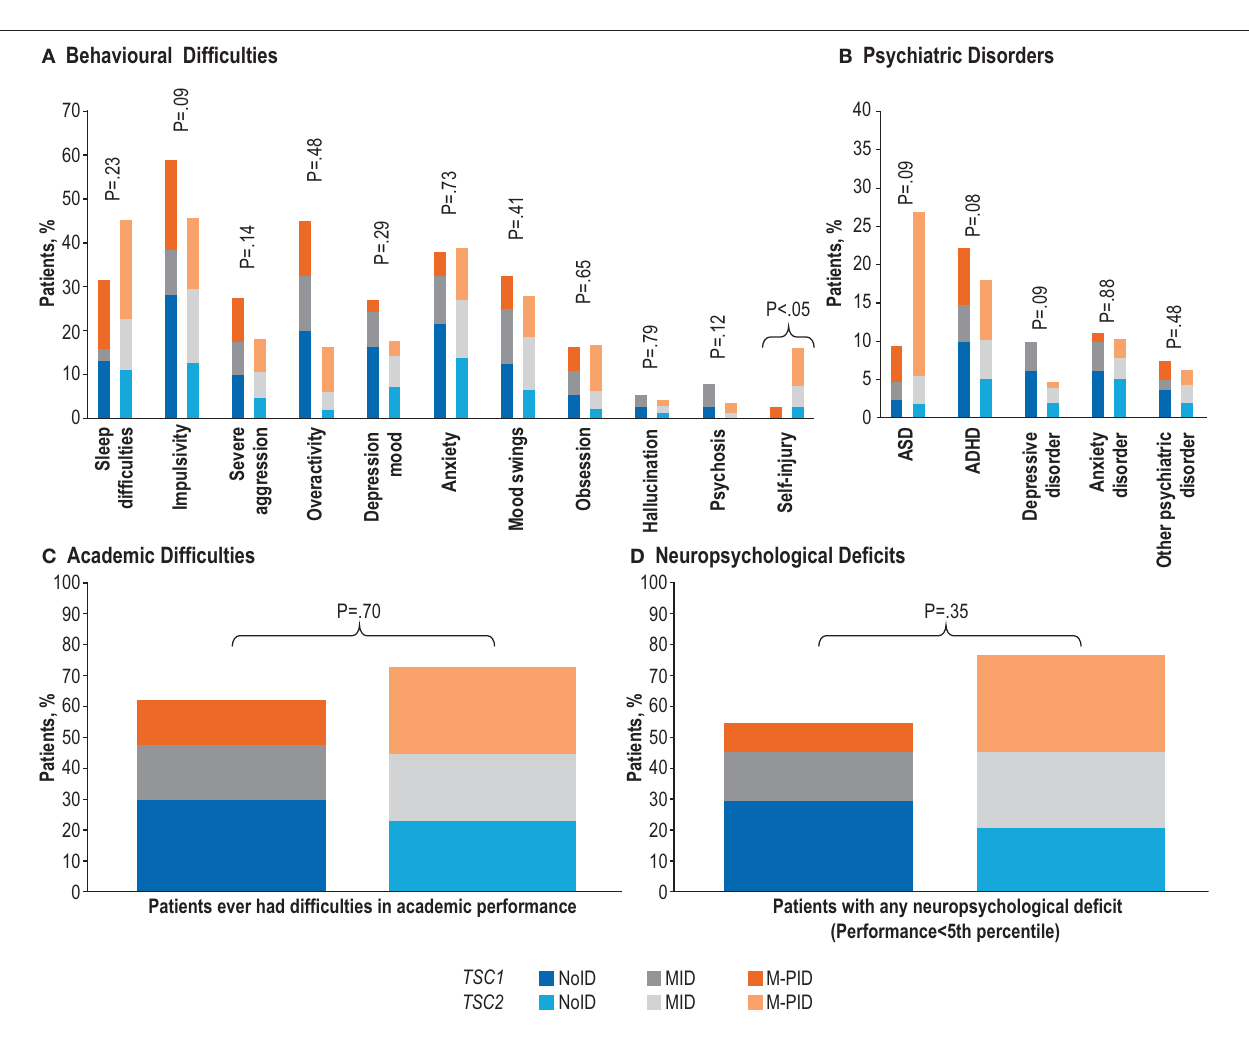
limitations are, at least in part, off-set by the large-scale and “real- world” nature of the cohort across multiple centers and